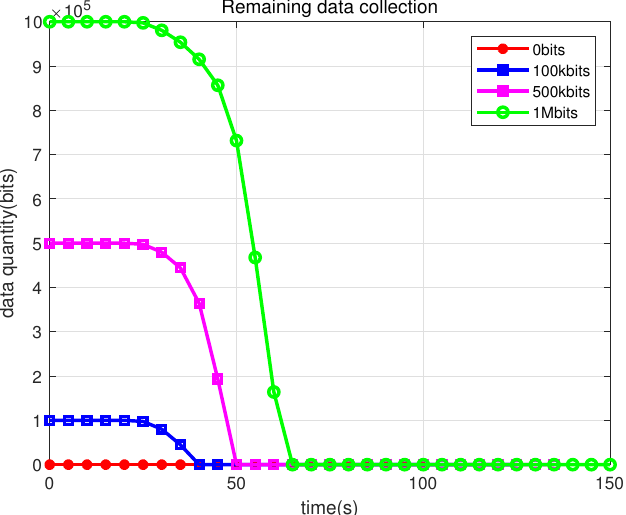
Figure 10. Variation in the amount of data remaining for different data collection